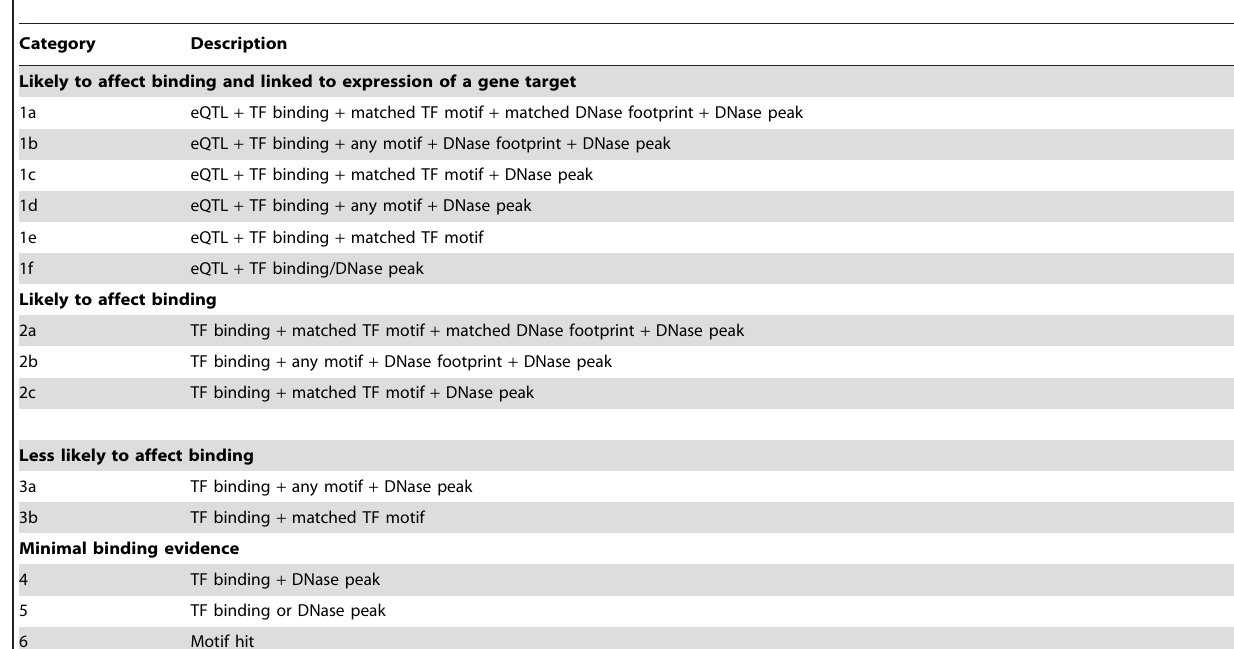
Table 2. RegulomeDB category summaries